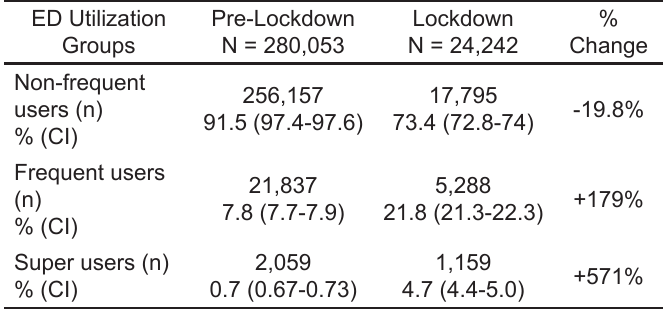
Table 3. Emergency department utilization groups pre-lockdown vs during lockdown.